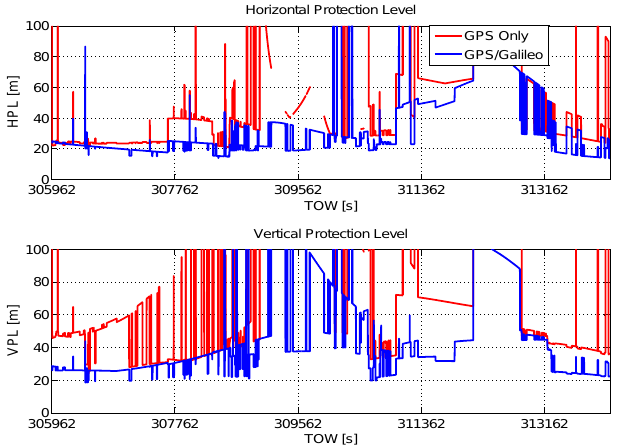
Figure 3. Horizontal protection limit (HPL) and vertical protection limit (VPL) as a function of time. Benefits of the inclusion of Galileo measurements in terms of HPL and